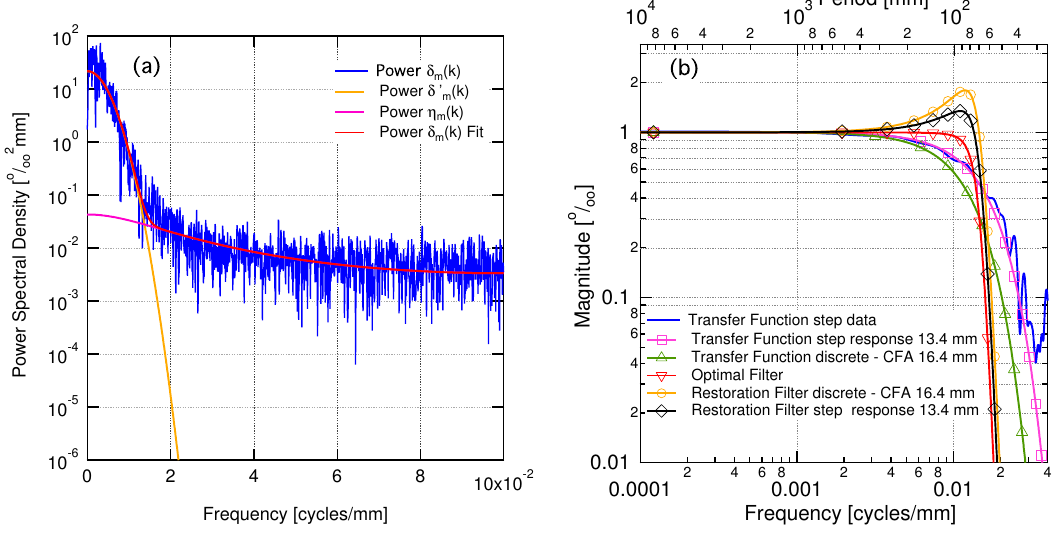
Fig. 8. (a) Power spectral density of δ D. (b) Transfer function calculated based on the step response with σ cfa = 13 . 4mm (pink – squares) and the comparison between discrete and CFA analysis with σ cfa = 16 . 4mm (green – triangles). Restoration filters built considering the two different transfer functions are illustrated with orange circles ( σ cfa = 16 . 4mm) and black diamonds ( σ cfa = 13 . 4mm).